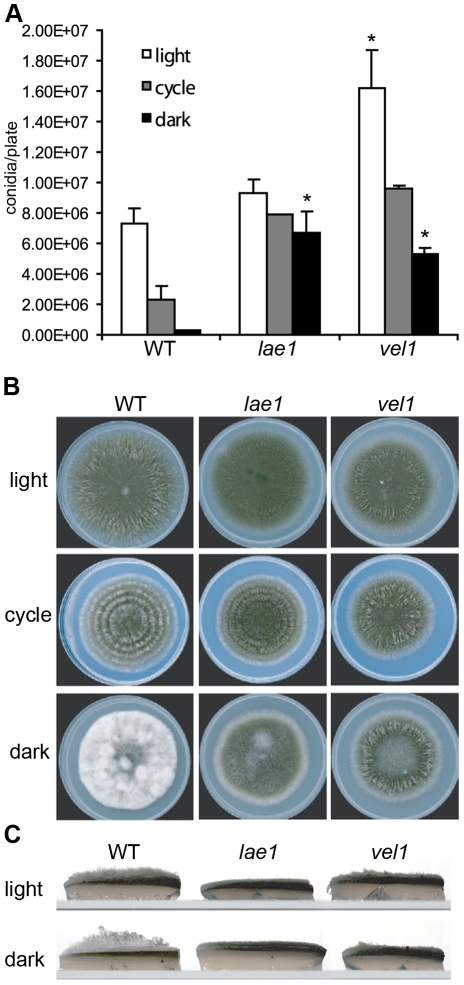
Repression of asexual sporulation in the dark and under cycling conditions is compromised in Chlae1 and Chvel1 mutants growing vegetatively.
A. Quantification of asexual spores from cultures grown under constant light, 12 hour light/dark cycle, and dark conditions. Error bars are standard deviation. Asterisks represent p-value <0.05 in T-test analysis in which each mutant strain was compared with the corresponding WT C4 strain under the same conditions. Asexual sporulation is repressed in WT in the dark or under the light cycling conditions, while this was not observed for the Chlae1 mutant. Absence of ChVEL1 augments asexual sporulation regardless of the light condition. B. Cultures grown on CMX plates under constant light, 12 hour light/dark cycle and constant dark conditions. Note that in the dark, WT C4 is white and fluffy reflecting aerial hyphal growth and production of very few conidia, while Chlae1 and Chvel1 mutants are pigmented. Alternating light and dark conidial banding pattern of the WT strain C4 in middle panel indicates that conidiation of the WT strain is responsive to light. This banding pattern is absent or much reduced in the Chvel1 mutant, but still evident in the Chlae1 mutant. C. Side view of plates of WT strain C4, and the Chlae1 and Chvel1 mutants grown in constant light or dark on CMX. Note aerial hyphae on plates of WT, especially from the dark. In contrast, the surface of the Chlae1 mutant is very flat while the Chvel1 mutant shows a small amount of aerial hyphae. Thus Lae1 appears to play a greater role in promoting aerial hyphae growth than Vel1.